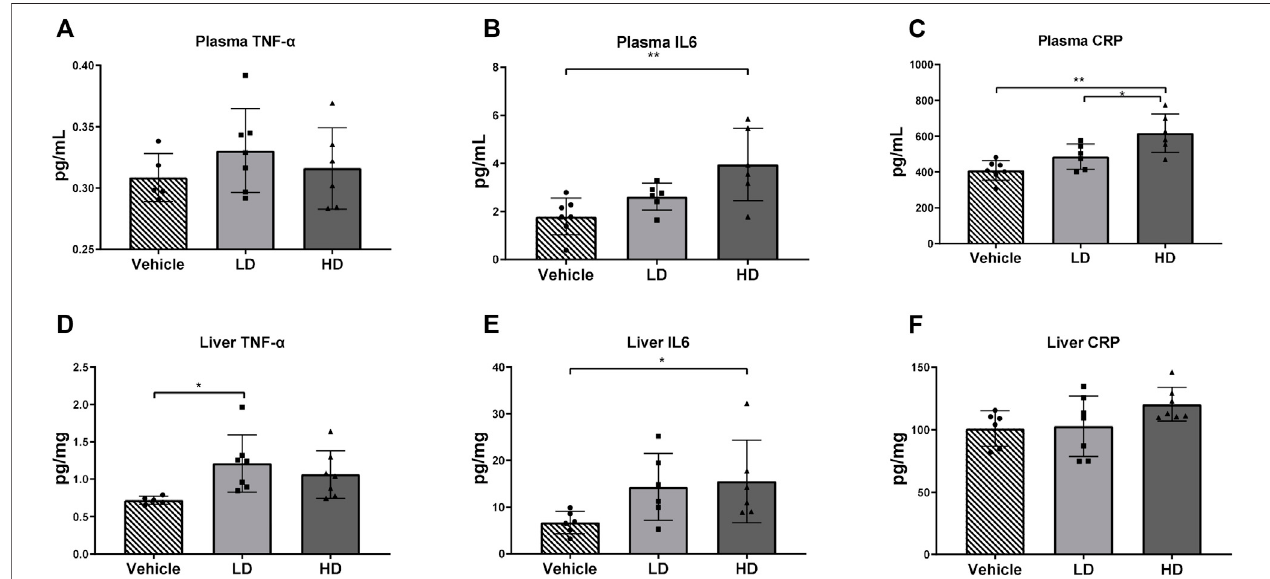
FIGURE 5 | TM-induced ERS triggers the in fl ammatory reaction in piglets. Piglets were administered with TM LD (0.1 mg/kg body weight), HD (0.3 mg/kg body weight), or vehicle for 48 h. (A – C) Plasma level of TNF- α , IL-6, and CRP in different groups. (D – F) Hepatic level of TNF- α , IL-6, and CRP in different groups. * means p < 0.05; ** means p <